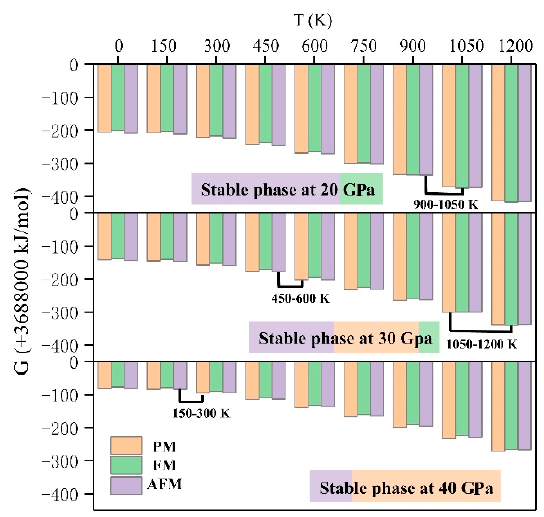
Figure 4. The Gibbs free energy G (T) of the PM, FM and AFM phases for (Ni,Cu) 3 (Al,Fe,Cr) at 20, 30 and 40 GPa.